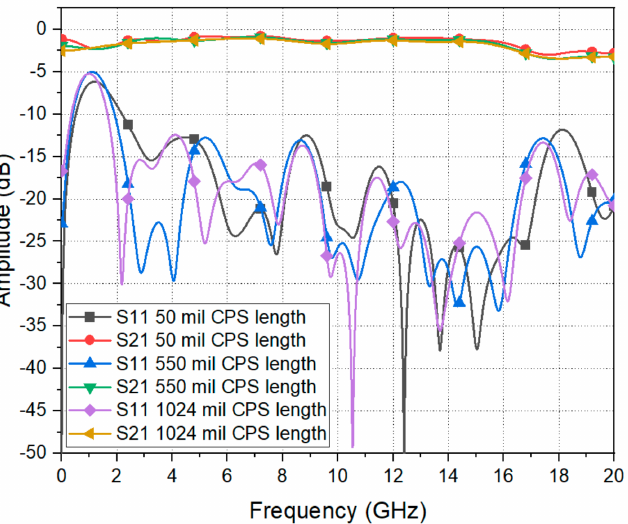
Figure 10. Simulated S-parameters of the back-to-back structures as varying the CPS line length. (In the proposed back-to-back transition, a 1.3 mm (50 mil) CPS line is